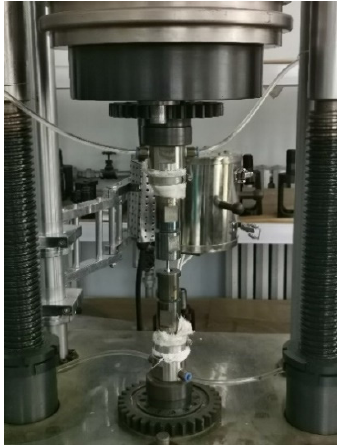
Figure 3. QBG-50 High-frequency fatigue tester.